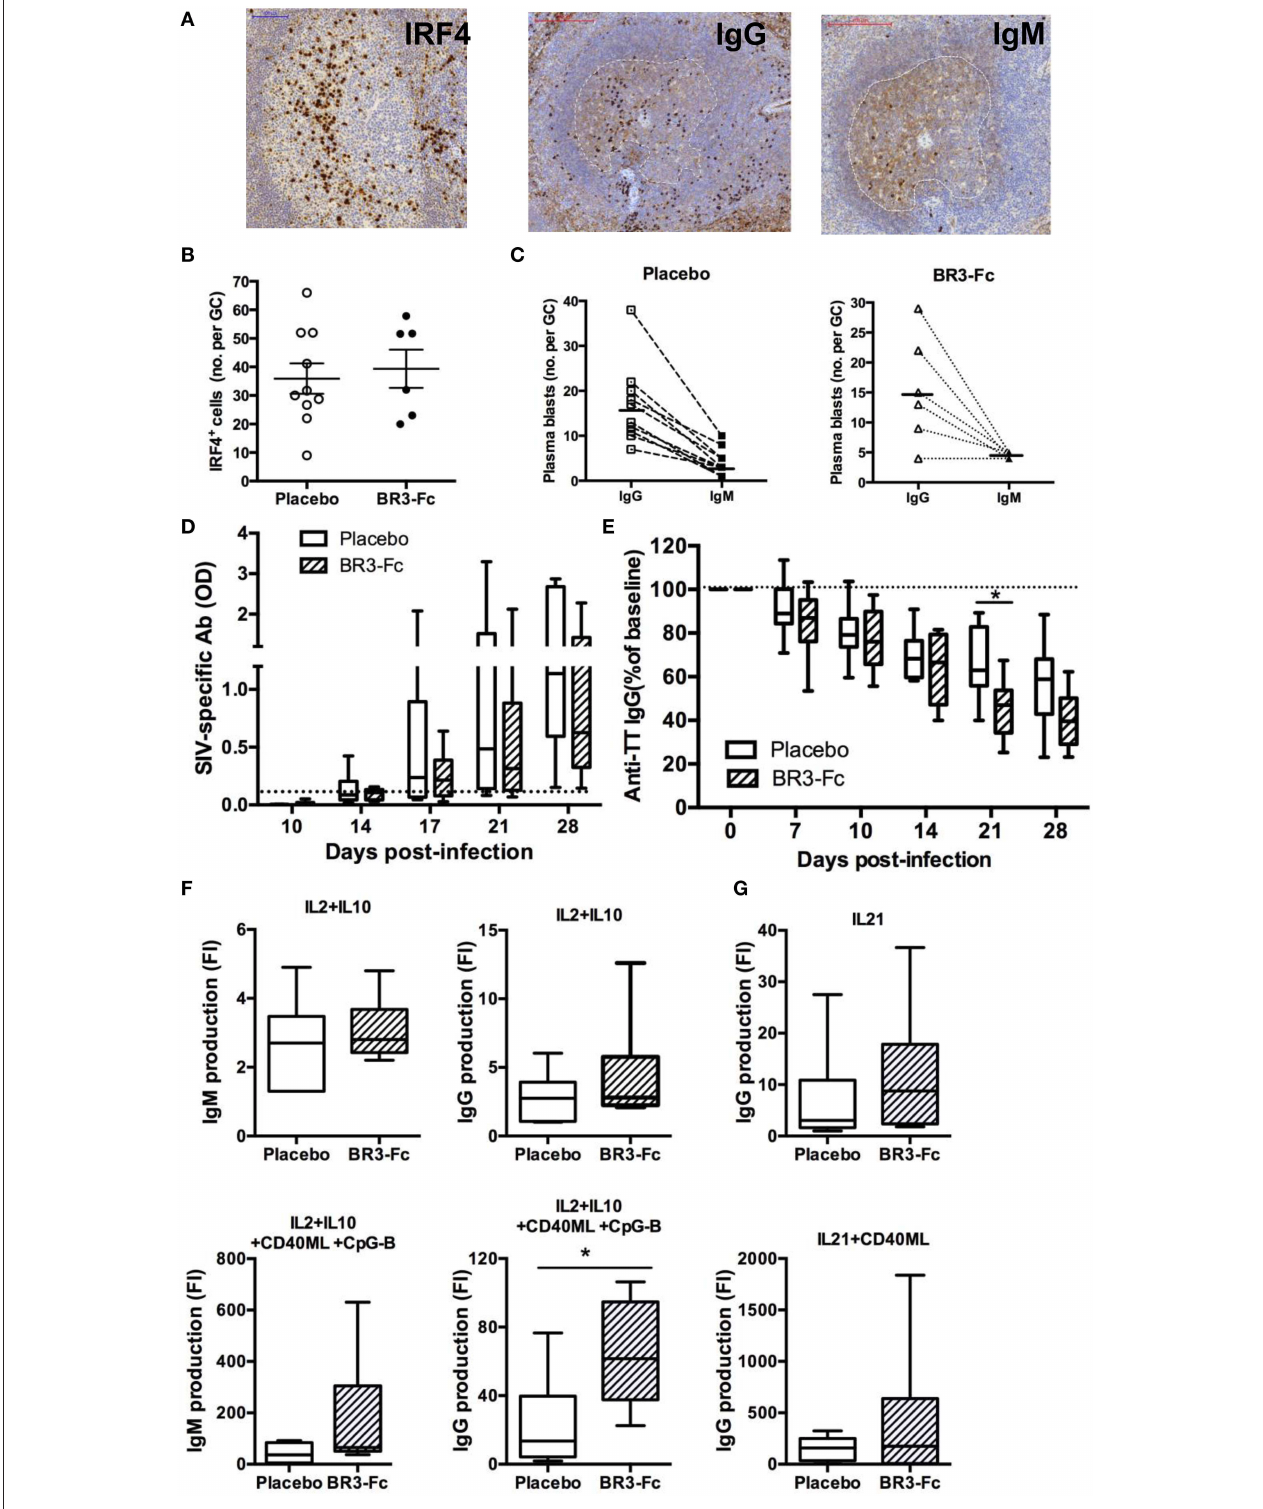
FIGURE 6 | Higher production of IgG/M by spleen B-cells from Treated macaques than Placebo. (A) Representative IRF4, IgG and IgM staining on sections of one Placebo macaque. For IgG and IgM staining, a dotted white line surrounds the GC area. (B) Graph represents the mean number of IRF4 + cells per GC for each